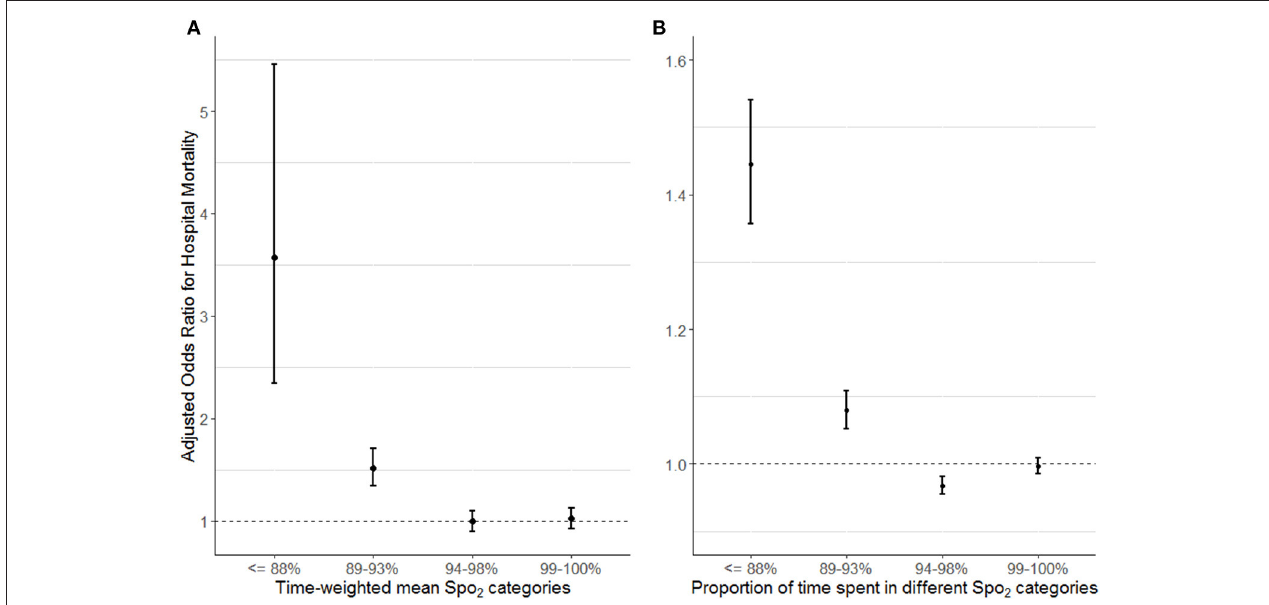
FIGURE 2 | Left (A) Adjusted odds ratio for hospital mortality according to different TWM-Spo 2 categories. The adjusted odds ratio for each Spo 2 level and 95% confidence intervals (error bars) were calculated (TWM-Spo 2 of 94–98% as reference). Right (B) Adjusted odds ratio for hospital mortality according to PTS-Spo 2 categories separately. An odds ratio is calculated per 10% increase in time in each given category. All models (i.e., five models, one for “ A ” and four for “ B ”) were separately adjusted for age, BMI categories, admission diagnosis, diabetes mellitus, Sequential Organ Failure Assessment score (not including points for the respiratory part), TWM-Fio 2 , TWM-Paco 2 , and TWM-pH categories. TWM, time-weighted mean; Spo 2 , peripheral oxygen saturation; PTS, proportion of time spent; BMI, body mass index; Fio 2 , fraction of inspiration oxygen; Paco 2 , partial pressure of arterial carbon dioxide. Full multivariable models